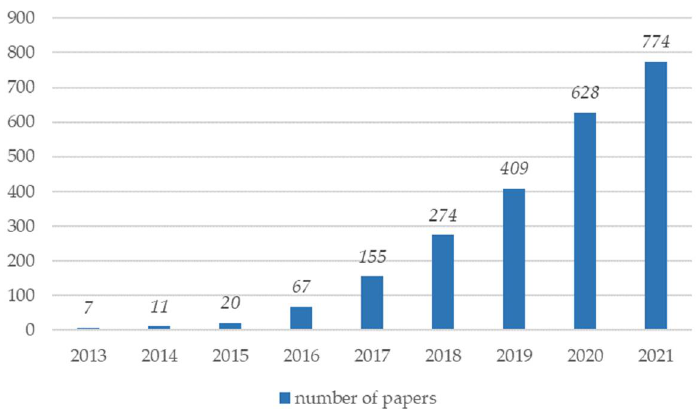
Figure 3. The number of SDG-related papers in the database from 2013 to